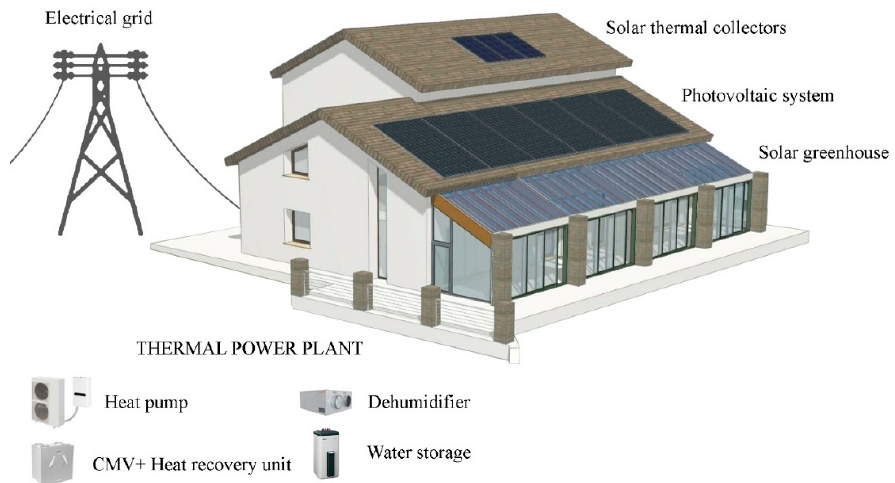
Figure 2. Schematic representation of the case study’s systems.